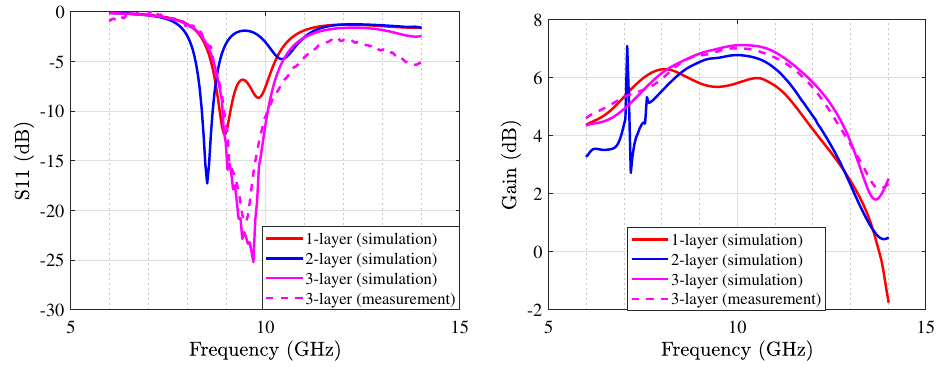
Figure 9. S 11 parameter of antenna-1 (left); gain of antenna-1 (right).